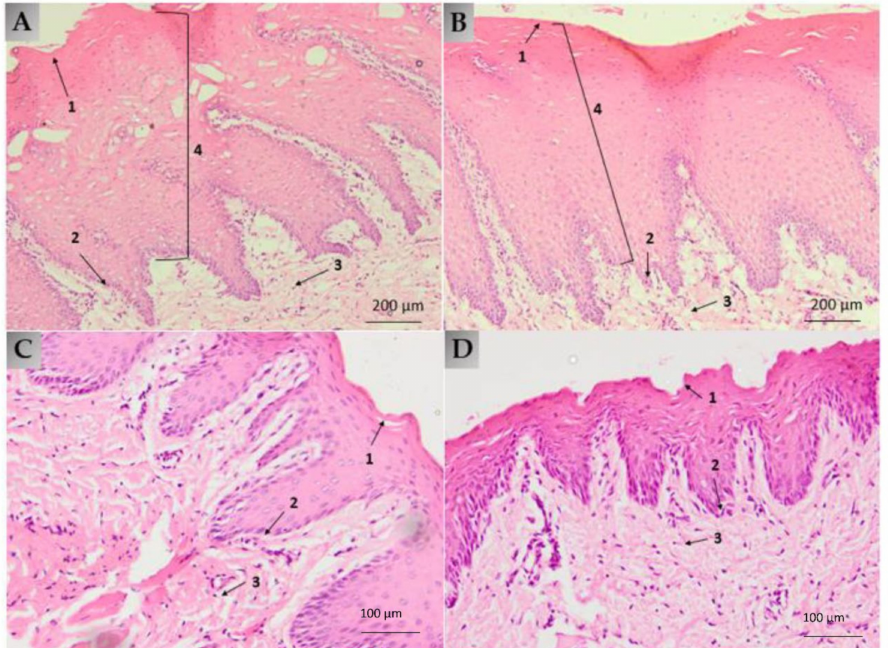
Figure 7. ( A ) Buccal mucosa histology under basal conditions, without gel (100 × magnification); ( B ) buccal mucosa histology after 2 h gel exposure (100 × magnification); ( C ) sublingual mucosa histology under basal conditions, without gel (200 × magnification); ( D ) sublingual mucosa histology after 2 h gel exposure (200 × magnification). (1) Keratinized or non-keratinized stratified squamous epithelium; (2) basal layer; (3) lamina propria; (4) dermal